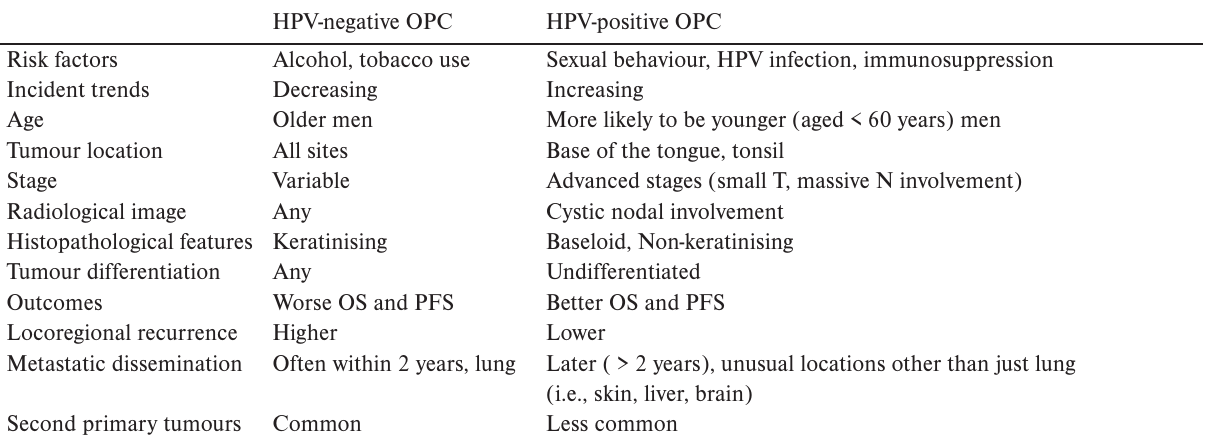
Table 1. Characteristics of patients with HPV-positive and negative oropharyngeal carcinoma.